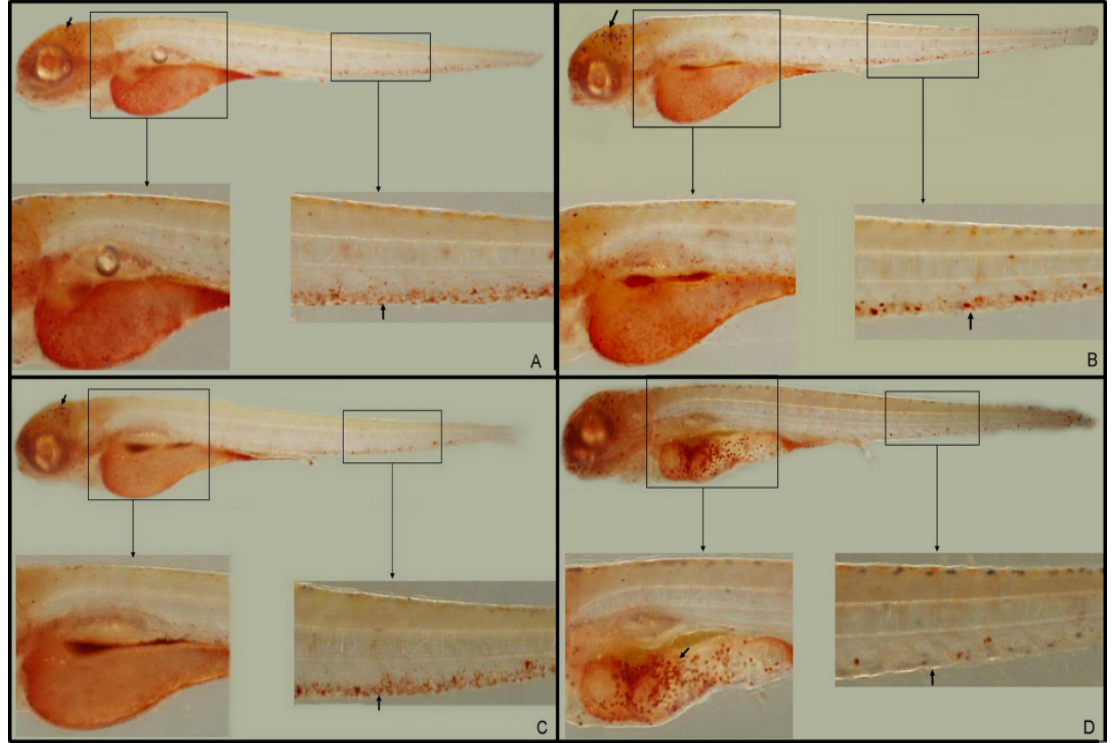
Figure 2. Representative pictures of NR labeling of macrophages at 3.5 dpf. ( A ) Normal untreated controls; ( B ) zebrafish larvae immersed in LPS (0.5 mg/mL); ( C ) PBS-injected negative controls; and ( D ) larvae with LPS (0.5 mg/mL) injected into the yolk ( n =